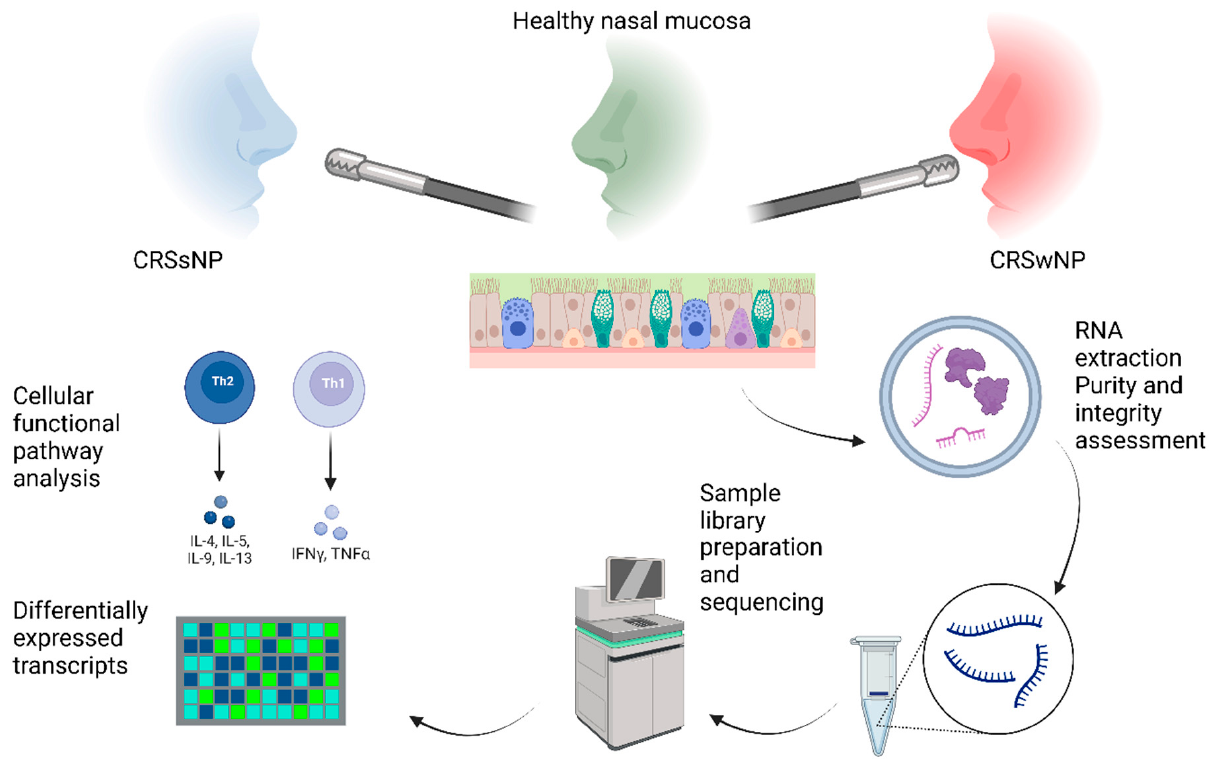
Figure 6. Graphical-study flowchart depicting several steps from initial tissue biopsy to RNA extraction, assessment of RNA quality, sample library preparation, and sequencing, with final stages of DEG and functional analysis using QIAGEN’s Ingenuity ® Pathway Analysis (IPA ® , QIAGEN, www.qiagen.com/ingenuity (accessed on 20 November